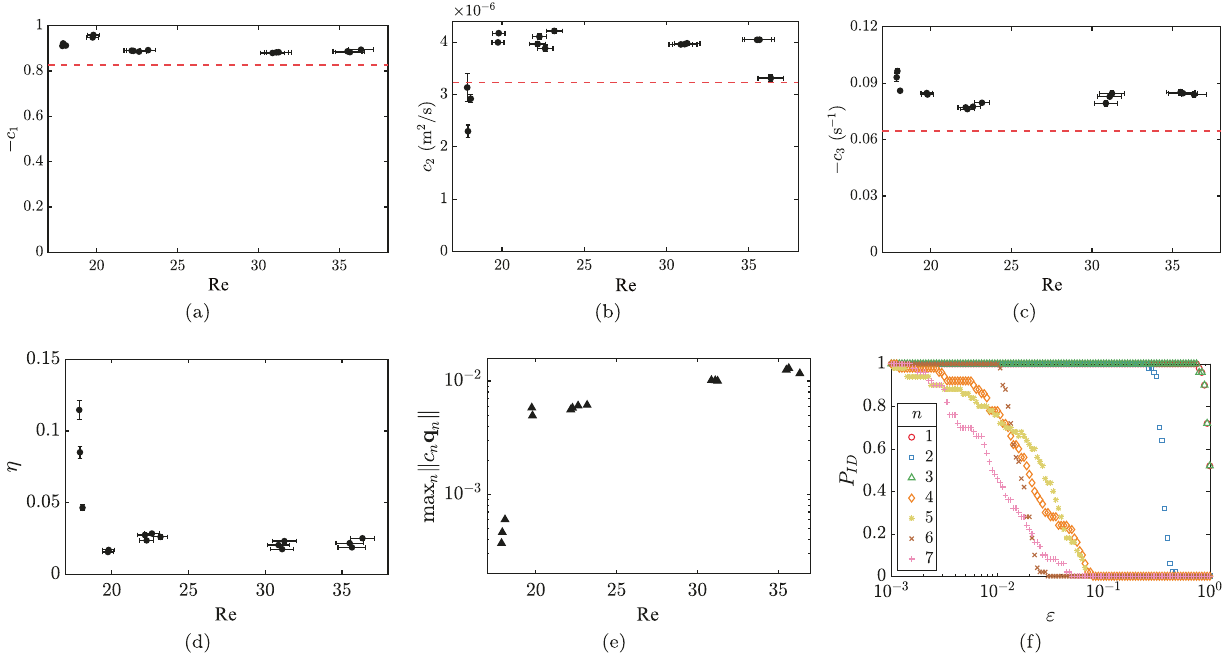
Fig. 3 Regression results. Model parameters, shown in ( a – c ) are consistently well estimated from experimental data for a range of Reynolds numbers Re, particularly when the amplitude of fl ow time dependence is suf fi ciently large, as illustrated in ( d ) and ( e ). For the results shown, fl ows in experiments are time-periodic for Re ≲ 19, and weakly turbulent otherwise. In ( a – c ), parameters obtained using ensemble averaging (black dots) are compared with the corresponding value obtained using fi rst-principle analysis (dashed line) performed for time-independent fl ows at low Re . In ( d ), low values of the residual η (Eq. 7) indicate good parameter fi ts; the relative quality of fi t deteriorates in a regime ( Re ≲ 19) where fl ow time dependence is weak and, therefore, the maximum magnitude of terms in Eq. (6) is small (e). The terms retained in a parsimonious model depend on a choice of threshold ε ; the probability of retaining the term F n as a function of ε shown in ( f ) indicates the model given by Eq. (8) is consistently identi fi ed by choosing 0.1 ≲ ε ≲ 0.3. The vertical error bars in ( a – d ) represent the standard deviation over the ensemble (in most instances they are smaller than the symbol size) and the horizontal error bars represent the variation in Re over the data